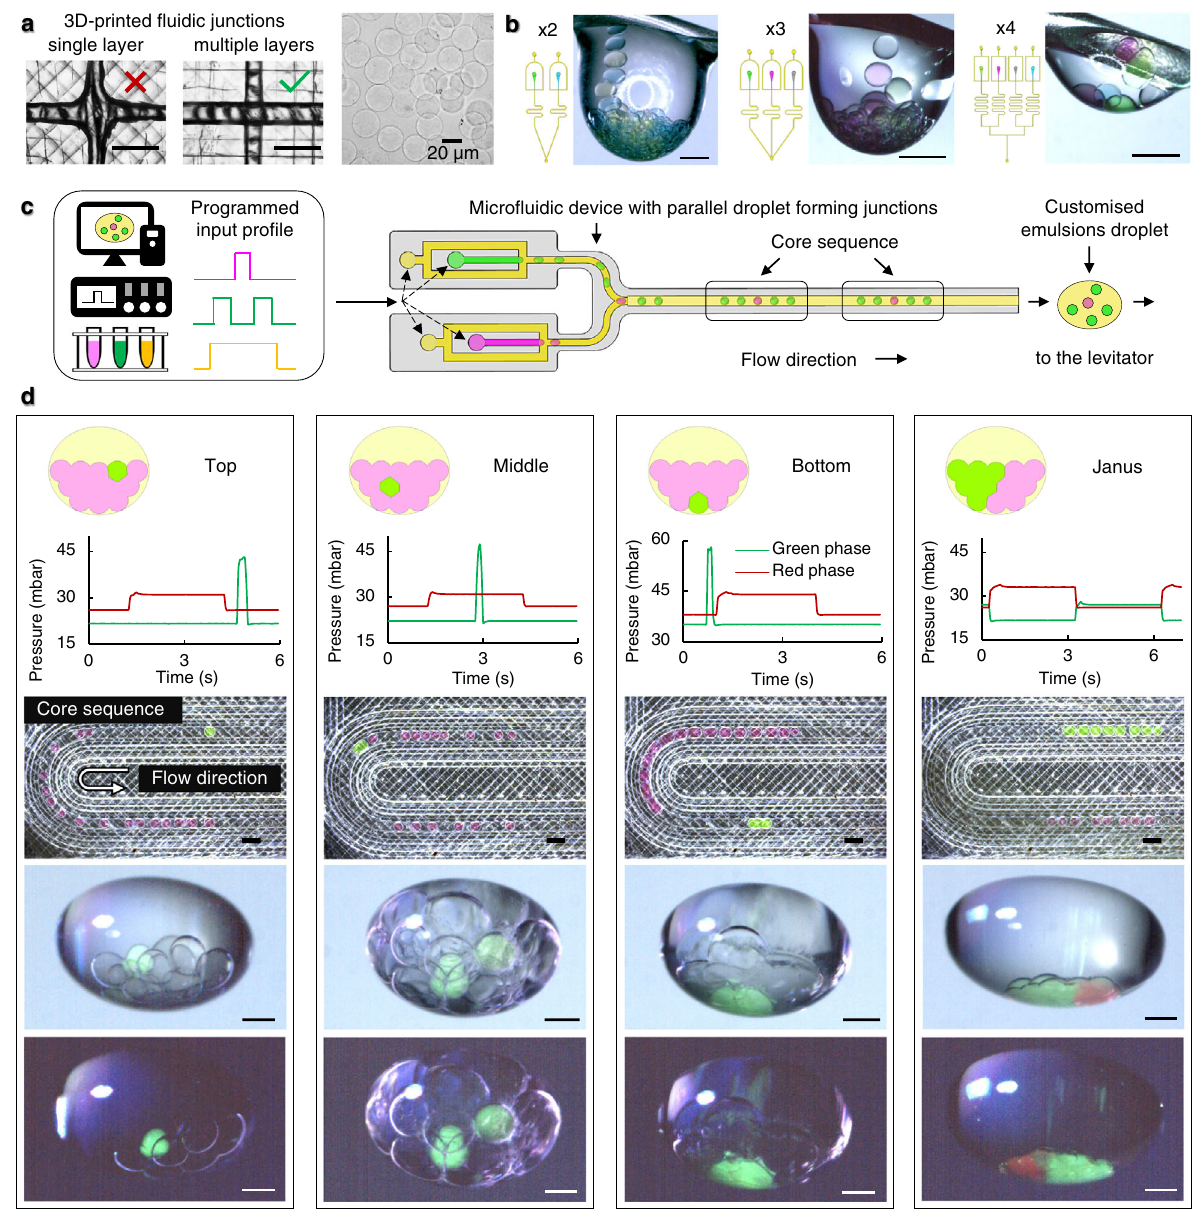
Fig. 2 Micro fl uidic control of arti fi cial cells with distributed cores (ACDC droplet) structural organisation. a Multi-layered 3D printing minimises capillary junction size, improving droplet generation fi delity, in comparison to single-layered devices (left), see Fig. S4 for further details. Uniform,